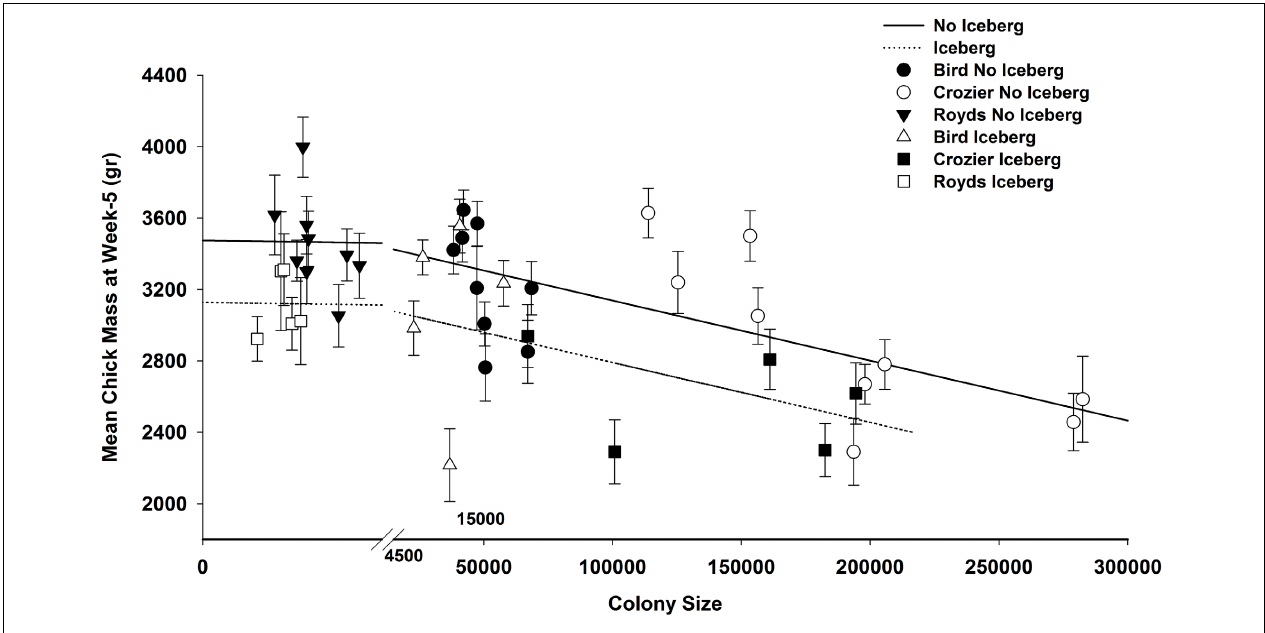
FIGURE 4 | Predicted mean mass (gr; with 95% confidence limits) of chicks at 5 weeks post-peak hatch date from best model plotted against colony size, for Adélie penguin at Cape Royds, Bird, and